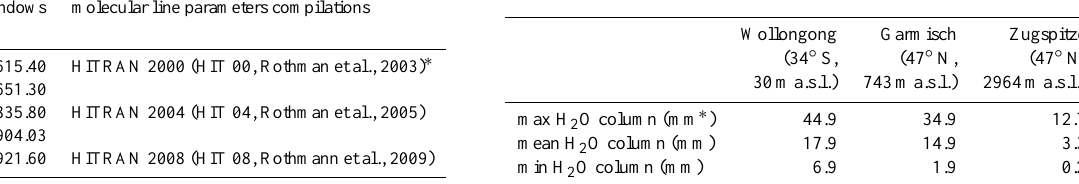
Table 1. Spectral micro windows and molecular line parameters compilations investigated in this study to find an optimum retrieval strategy.